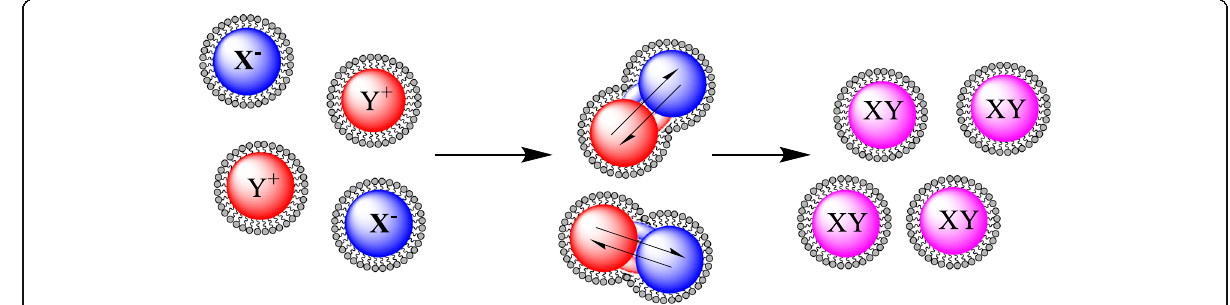
Fig. 2 A generic representation of the interaction of reverse micelles containing salts the react to form metal